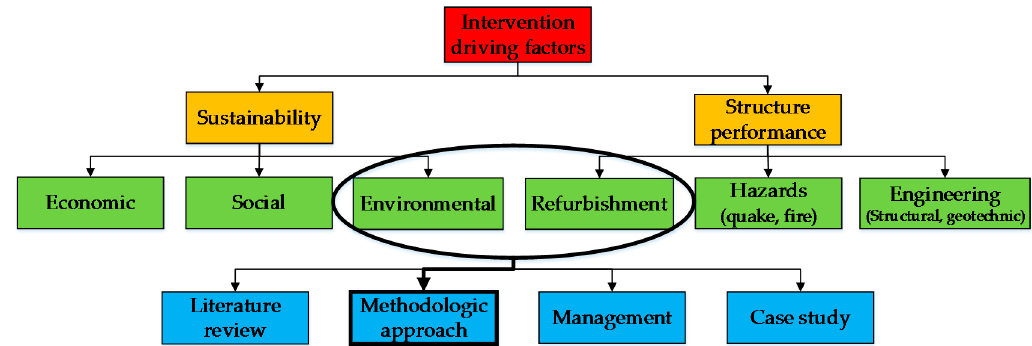
Figure 1. Flow diagram for the content review of the documents. Step 1 groups the documents according to the focus of publication (orange cells), step 2 categorizes them according the field of publication (green cells), and step 3 identifies the type of contribution (blue cells).